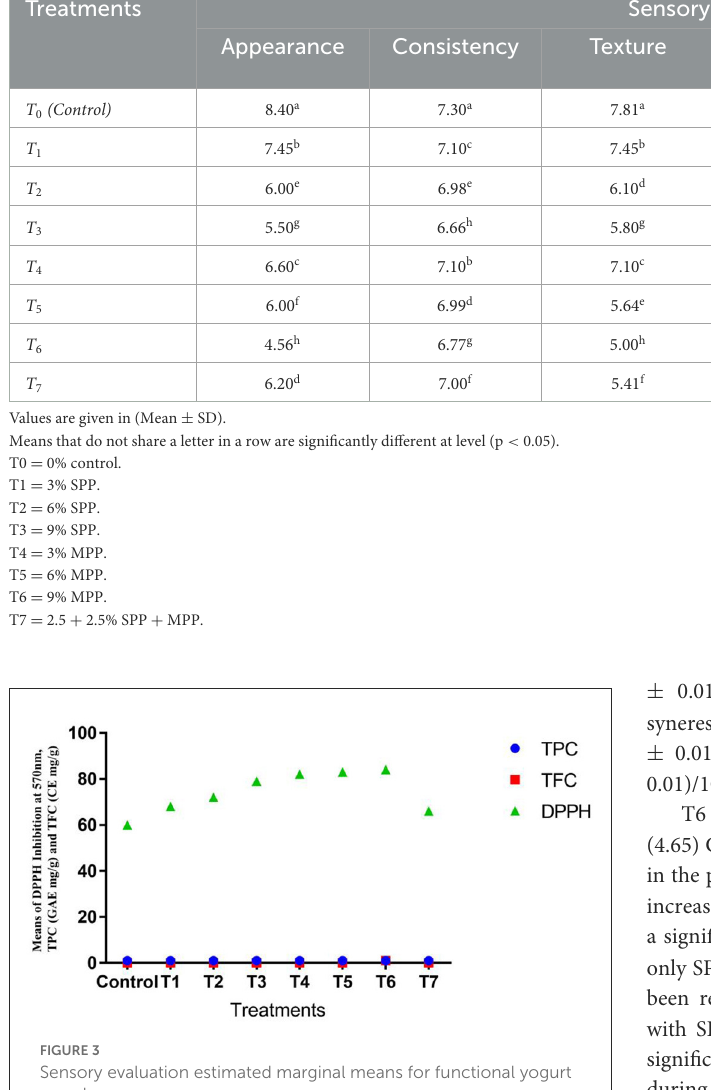
TABLE 8 Effect of adding SPP and MPP on the sensory profile of Yogurt. Treatments Sensory attributes Appearance Consistency Texture Flavor Taste Overall